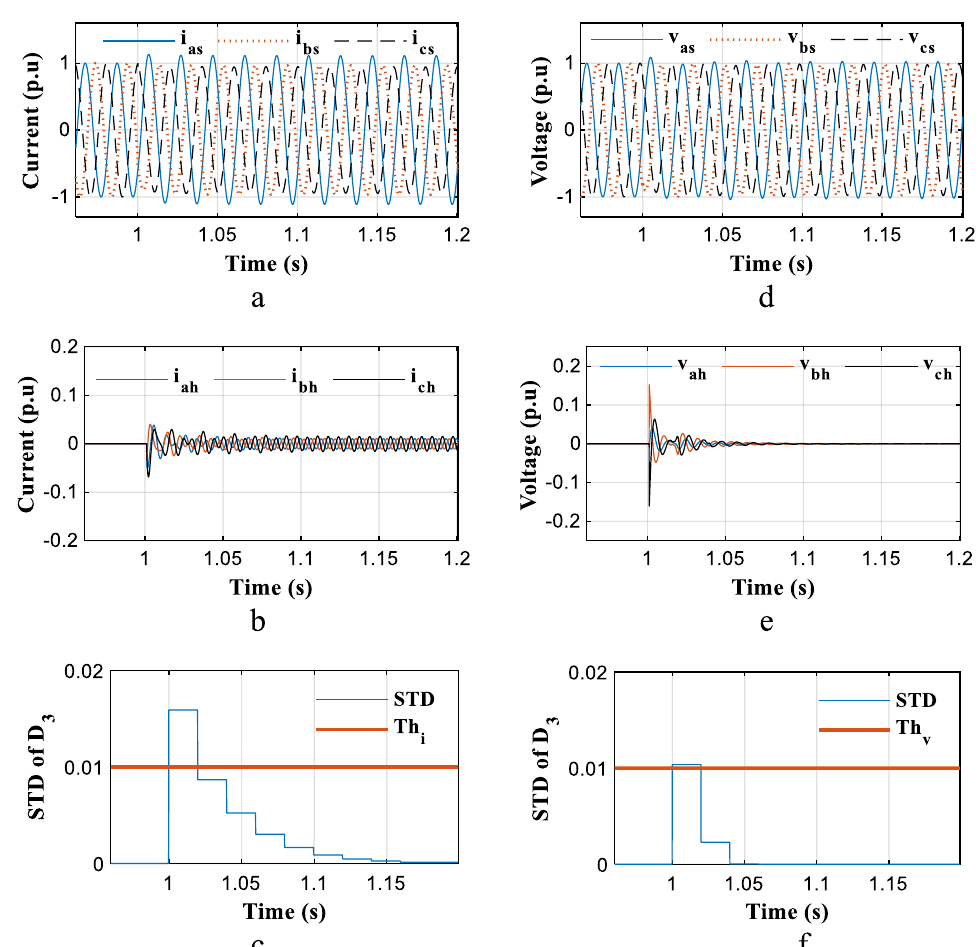
Fig. 12 Performance evaluation of proposed criteria using simulation results for an unbalance voltage of 2.64%, a Three-phase stator current signals, b High-frequency components of three-phase stator current signals, c The current criterion, d Three-phase stator voltage signals, e High-frequency components of three-phase stator voltage signals, f The voltage